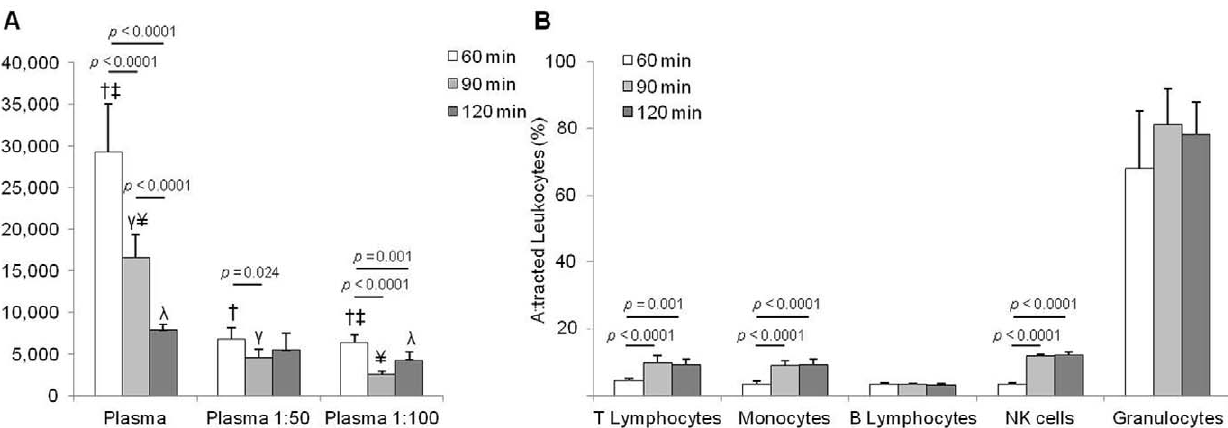
Figure 4. A) Robustness of CBFCA. To investigate the robustness of CBFCA the leukocyte chemotactic activity of undiluted and diluted plasma was determined in time course experiments. CBFCA was able to determine the biological chemotactic activity of diluted and undiluted plasma at 60, 90 and 120 min. B) Robustness of the incubation time in CBFCA. CBFCAs were performed at different incubation times (60, 90 and 120 min) using total leukocytes and plasma. All the leukocyte subsets reached the top of their migration within 90 min and their proportions did not change